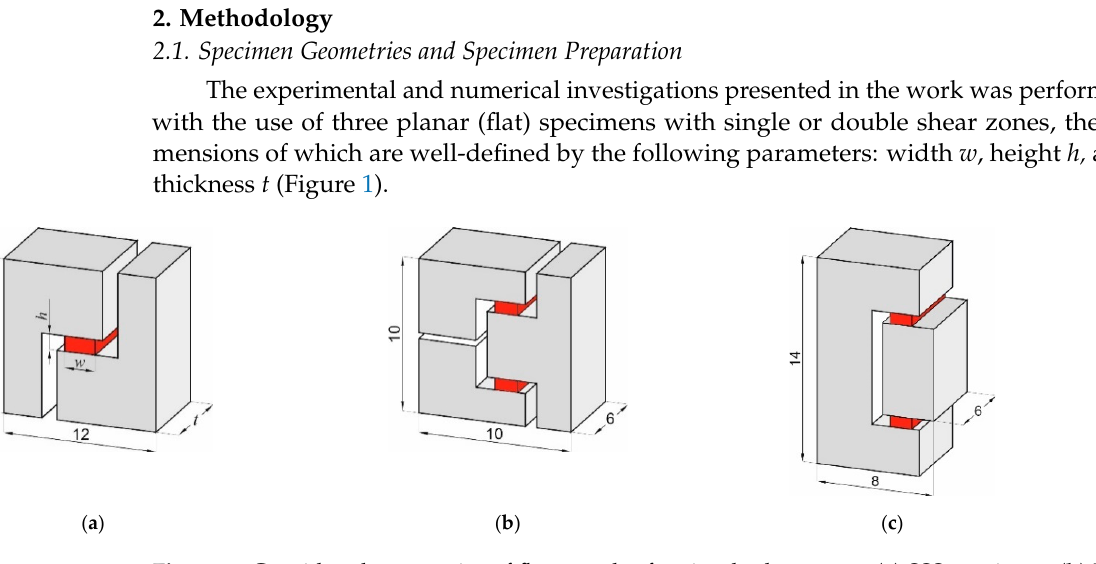
Figure 1. Considered geometries of flat samples for simple shear tests: ( a ) SSS specimen; ( b ) DSS specimen; ( c ) D2S specimen.